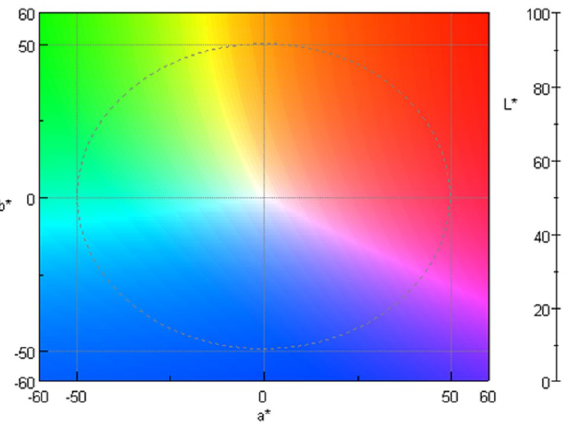
Figure 2. Representation of the CIE L*a*b* dimensional color space, where a* and b* represent the chromaticity and L* the lightness (White, L* = 100; Black, L* =